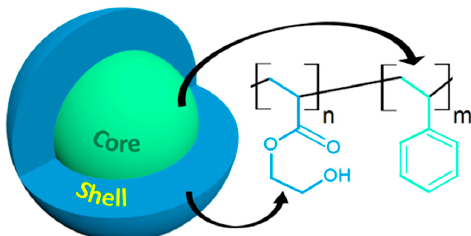
Figure 1. Schematic representation of poly(hydroxyethyl acrylate)– b –poly(styrene) (PHEA– b –PS) core-shell